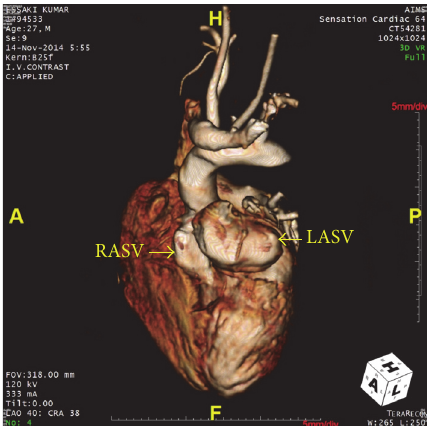
Figure 6: The 3D reconstructed image with MDCT aortogram revealed left aneurysm of sinus of Valsalva (LASV; size: 5.4 × 5.7 cm) and right aneurysm of sinus of Valsalva (RASV; size: 4.6 × 2.7 cm) with extension into the interventricular septum; left coronary artery arising from the roof of the left diverticulum.